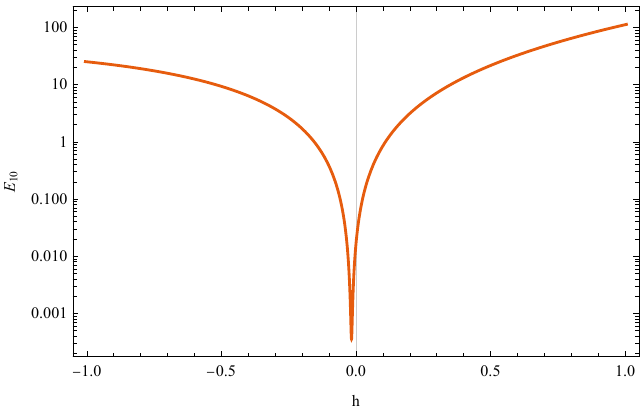
Figure 1. Logarithm of the squared residual E 10 .